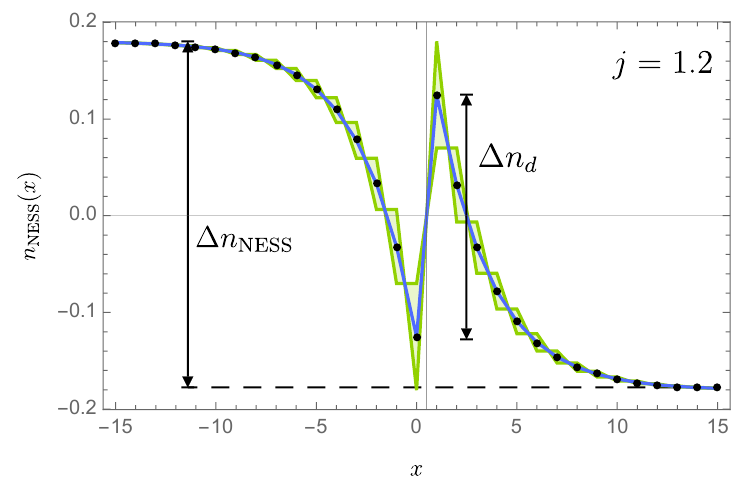
Figure 9: Finite distance features of the NESS density as a function of the position ( x , t ) for defect strength j = 1.2 > 1 (Eq. (43)). Dots and blue line: time n t →∞ averaged density profile, green lines: amplitude of persistent oscillations about the average value. The average density exhibits a step ∆ n (Eq. (45)) between the two d defect sites 0 and 1 that is inverted in comparison with the asymptotic averaged difference ∆ n (Eq. (44)) far from the defect. In contrast, for j < 1 the jump NESS between the defect sites is exactly the same as that far from the defect and the density profile is independent of the position, apart from this